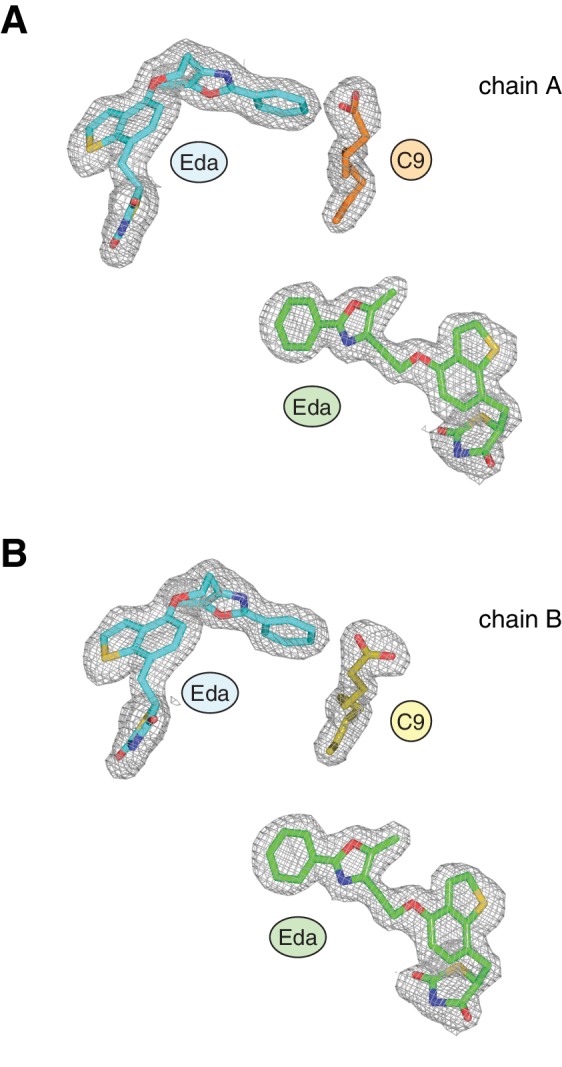
Omit map (2FO–FC, contoured at 1 σ) of the EDA and C9 ligands in the crystal structure.Ligands in chains A and B are shown in (A) and (B), respectively, and colored as follows: EDA bound to the canonical orthosteric pocket (blue), EDA bound to a surface pocket (green), and C9 bound to the alternate site (yellow and orange in chain A and B, respectively). Figure 3—figure supplement 2. The TZD head group of the second edaglitazone molecule docks into the PPARγ AF-2 surface (A,B) in a similar manner to a SRC-1 coactivator peptide bound to the AF-2 surface (C) in the crystal structure of rosiglitazone-bound PPARγ (PDB: 2PRG). The hydrophobic tail group of this second edaglitazone molecule packs within a surface pocket created by the Ω-loop and the loop connecting helix 11 and 12 (B). The second EDA ligand bridges interactions between two PPARγ molecules in different unit cells within the crystal lattice by binding to the Ω-loop region in one molecule (e.g., chain A) and the AF-2 surface of a symmetry related molecule (e.g., chain B’).